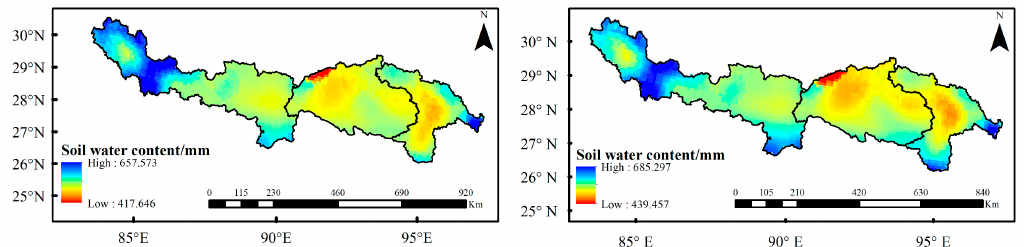
Figure 13. Annual ( left ) and growing season ( right ) spatial distributions of the soil water content.